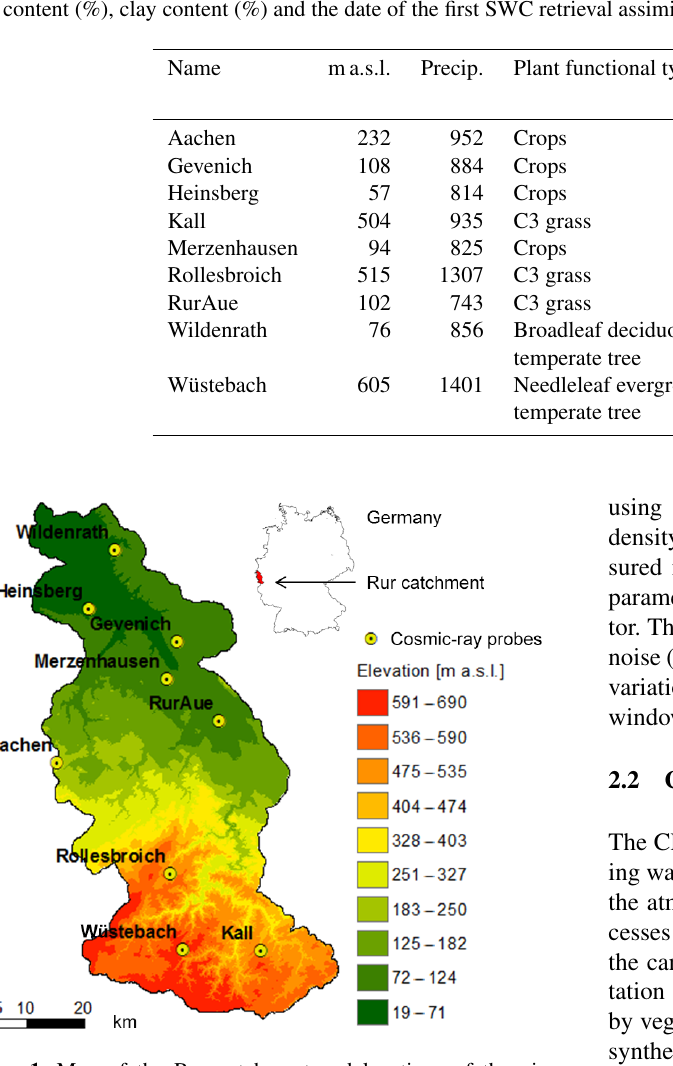
Figure 1. Map of the Rur catchment and locations of the nine cosmic-ray neutron sensors. The hilly south of the catchment is prone to more rainfall, lower average temperatures and less poten- tial evapotranspiration than the north of the